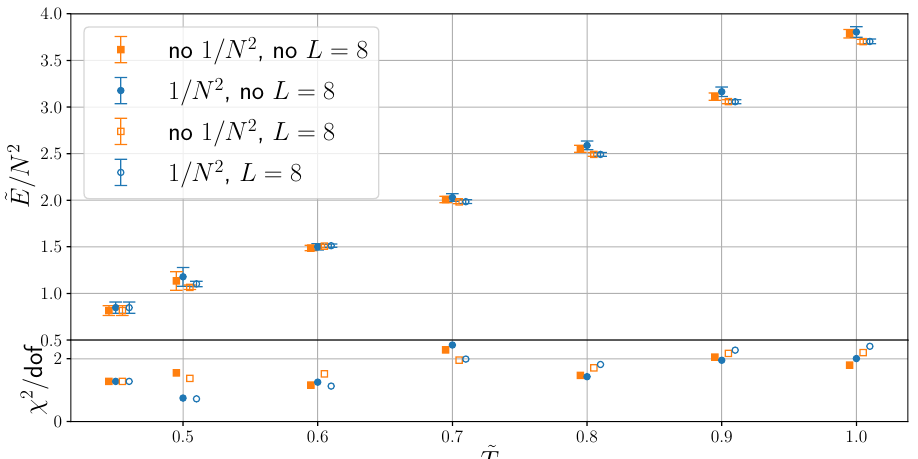
Figure 12. The values of the energy in the ungauged theory (and the reduced (cid:31) 2 ) as a function of the temperature from di(cid:11)erent simultaneous large- N and continuum extrapolations: with and without 1 =N 2 corrections and with and without L = 8 data